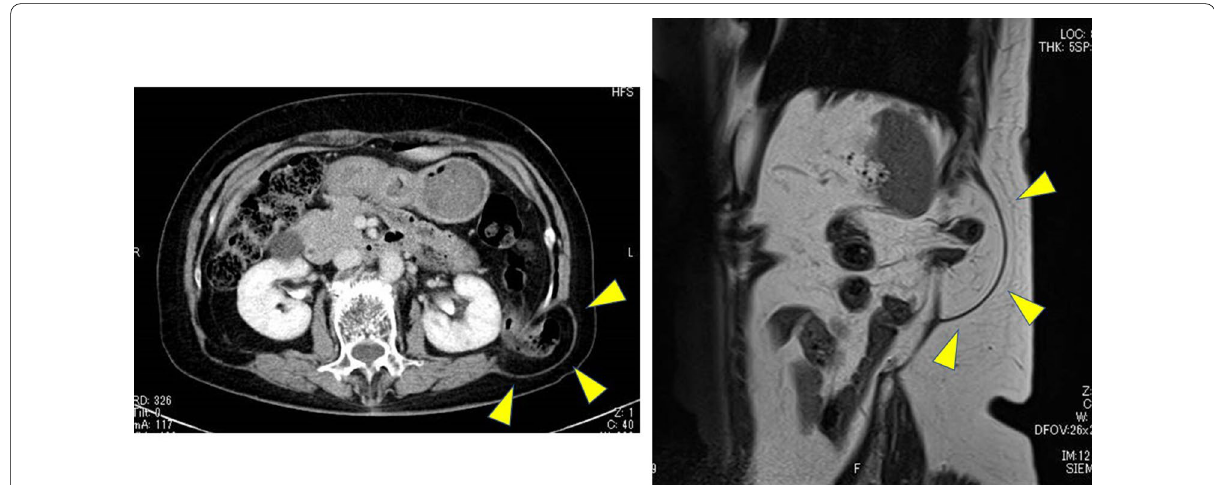
Fig. 1 Abdominal CT and MRI. The left: Preoperative computed tomography image. The right: preoperative magnetic resonance image. A fascial defect was in the left lumbar abdominal wall and in which retroperitoneal fatty tissue and the descending colon protruded (arrows)